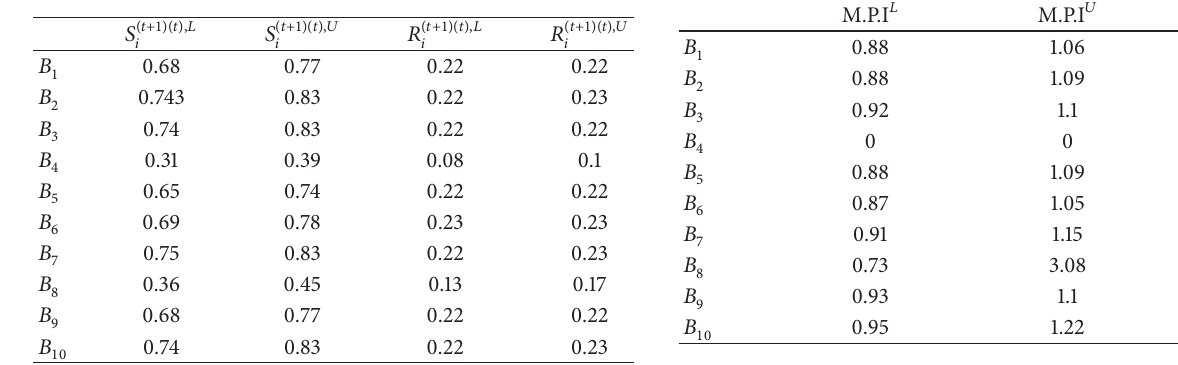
Table 18: Result of M.P.I and 𝜌